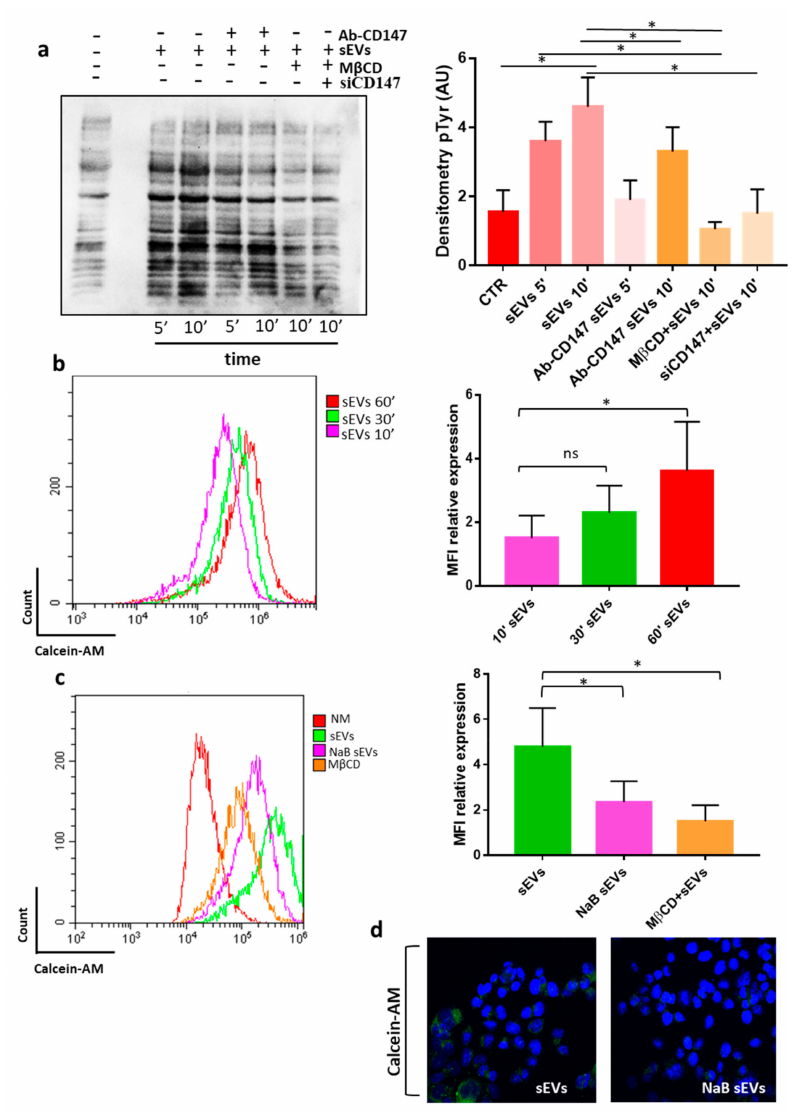
Figure 8. CR-CSC (colorectal cancer stem cell) derived sEVs (small extracellular vesicles) increase the phosphorylation state of intracellular proteins in recipient cells through a CD147-dependent mechanism. ( a ) Western blot analysis of phosphorylated tyrosines in HCT116 cells incubated for 5 (5’) or 10 (10 (cid:48) ) min with 10 µ g / mL of Re121-sEVs. Ab-CD147 = Re121-sEVs were pre-treated with anti-CD147 antibodies; m β CD = HCT116 were pretreated for 30 min with (1 mM) methyl- β -ciclodextrin, an inhibitor of EVs uptake; siCD147 = Cd147-knock down HCT116 cells; data representative of three independent experiments are shown by bar charts on the right; ( b ) cellular uptake of Calcein-AM labelled sEVs by HCT116 cells at di ff erent time-points (10 (cid:48) , 30 (cid:48) , 60 (cid:48) ); data representative of three independent experiments are shown by bar charts on the right; ( c ) sEVs released by undi ff erentiated CR-CSC cells are more e ffi ciently internalized by HCT116 cancer cells compared to sEVs released by NaB di ff erentiated Re121cells (NaB sEVs). The treatment of HCT116 recipient cells with methyl- β -cyclodextrin (m β CD) strongly prevented the uptake of sEVs; data representative of three independent experiments are shown by bar charts on the right; Graph bars ( b , c ) indicate the MFI (medium fluorescence intensity) of sEVs internalized and analyzed by flow cytometry. The images are representative of three independent experiments. ( d ) Immunofluorescence staining of HCT116 recipient cells treated for 1 h with sEVs stained with Calcein-AM, Magnification 600 × . *, p <